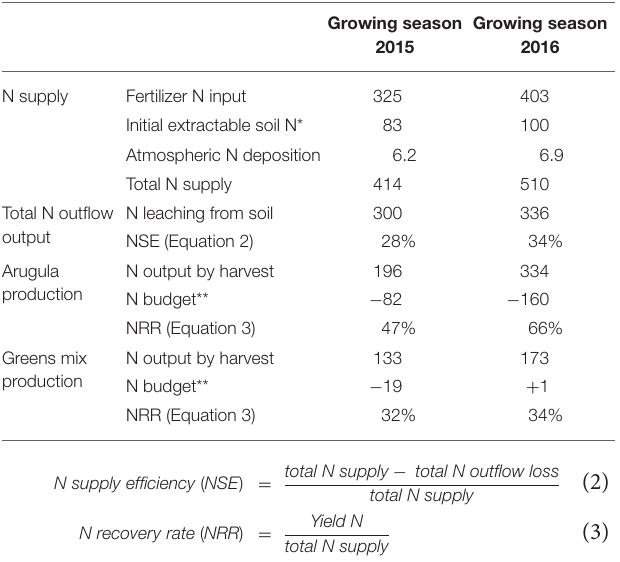
TABLE 2 | Efficiency of N management for leafy vegetable production at the Brooklyn Grange Navy Yard farm, NYC, in the 2015 and 2016 growing